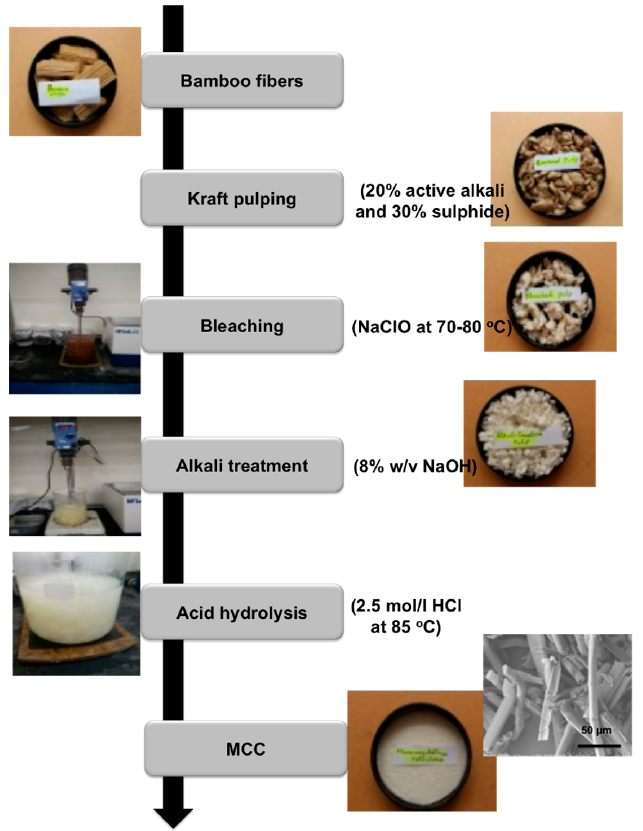
Figure 1. Isolation of MCC from bamboo fibers.